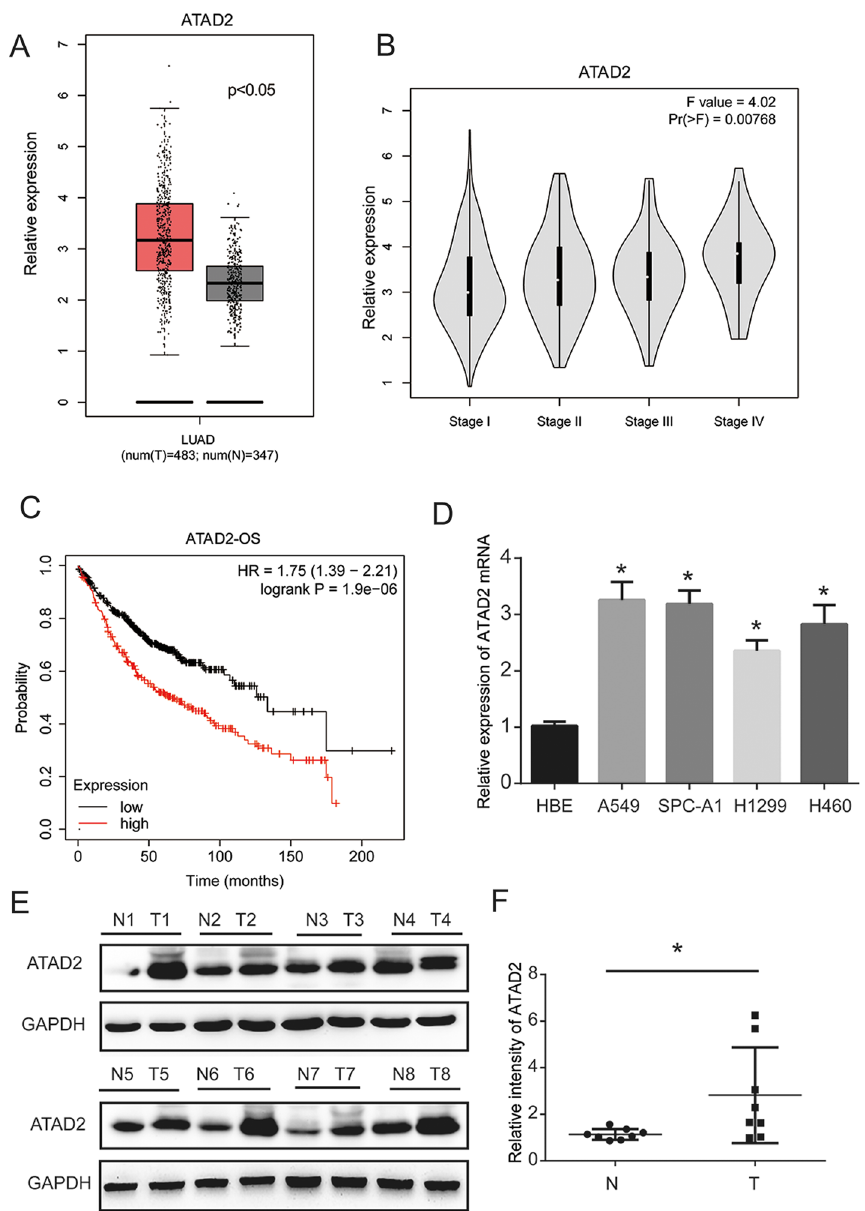
Fig. 1 ATAD2 expression is upregulated in LUAD tissues and cells. A Overexpression of ATAD2 mRNA is observed in LUAD tissues compared with normal samples [gene expression profiling interactive analysis (GEPIA)]. B ATAD2 mRNA expression is significantly related to the cancer stage of the patient (GEPIA). C Prognostic feature of mRNA expression of ATAD2 in LUAD patients (Kaplan–Meier plot). Overall survival (OS) curve comparing patients with high (red) and low (black) ATAD2 expression in lung cancer plotted using the Kaplan–Meier method with a threshold of p -value < 0.05. D mRNA expression of ATAD2 is increased in lung cancer cells compared with normal lung epithelial HBE cells. E , F Protein expression of ATAD2 is increased in the tissues of lung cancer patients. * p <